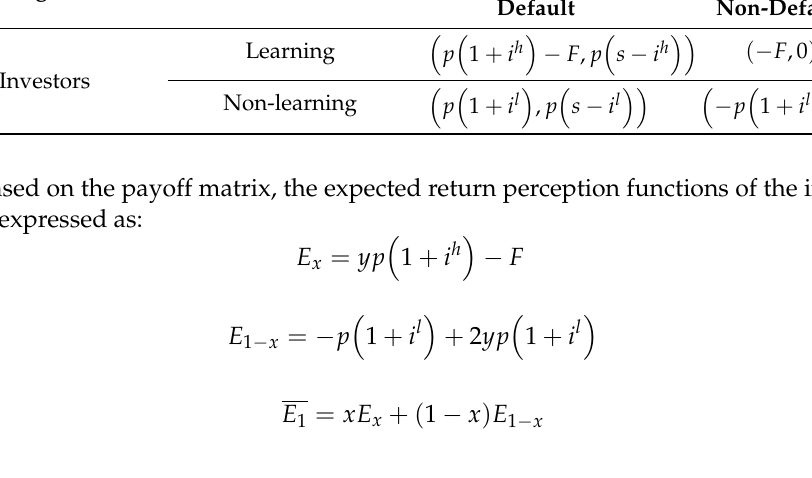
Table 2. The payoff matrix of investors and borrowers on inactive online lending platforms. Strategies of Investors and